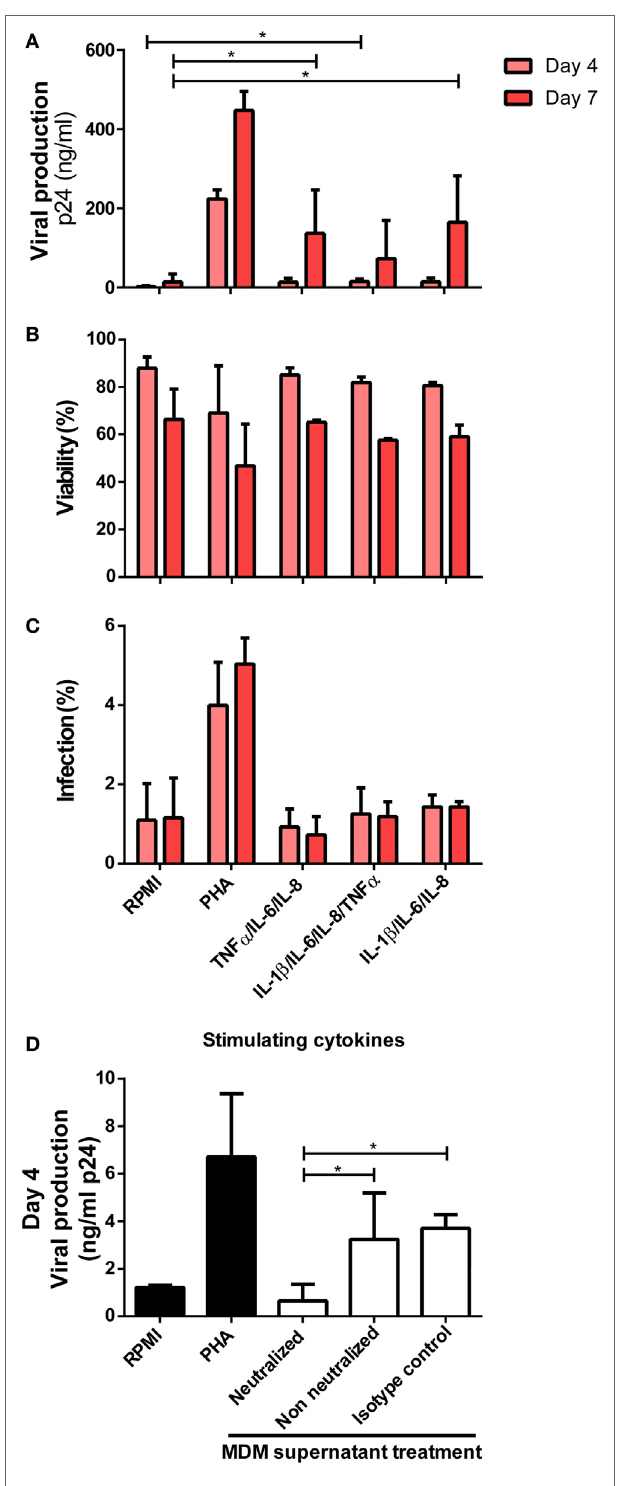
FigUre 7 | Identification of cytokines as responsible for enhancing human immunodeficiency virus type I (HIV-1) infection in unactivated CD4 + T-cells. (a) Unactivated CD4 + T-cells were stimulated with different combinations of cytokines for 72 h. Then, cells were infected and p24 antigen production was evaluated at days 4 and 7 post-infection. Each condition was compared with the corresponding RPMI condition (negative control). As a positive control, PHA stimulation was used. Percentage of living CD4 + T-cells (B) and percentage of infected (GFP + ) CD4 + T-cells (c) after stimulation with the denoted treatments are shown. Data represent mean ± SD from four independent donors evaluated in duplicate. Concentrations of cytokines used in these experiments corresponded to the average concentrations found in monocyte-derived macrophage (MDM) supernatants stimulated with 25 ng/ ml macrophage migration inhibitory factor (MIF) (peak effect) as follows: 250 pg/ml IL-6, 9,000 pg/ml IL-8, 1,400 pg/ml TNF- α , and 20 pg/ml IL-1 β . (D) Neutralization of IL-8, IL-6, IL-1 β , and TNF α biological activity with monoclonal neutralizing antibodies. Primary CD4 + T-cells were incubated with supernatants derived from the 25 ng/ml MIF-treated HIV-infected MDM neutralized previously with 18 µg/ml anti-IL-8, 20 ng/ml anti-IL-6, 2 µg/ml anti-IL-1 β , and 2 µg/ml anti-TNF α antibodies. Non-neutralized and isotype control antibody conditions were tested for comparison. Also, RPMI and PHA controls were included. Viral production was evaluated at day 4 post- infection. Data were analyzed by one-way ANOVA followed by Dunnett’s post-test (all conditions versus the corresponding RMPI control) in (a) and Tukey’s post-test in (D) . * p <